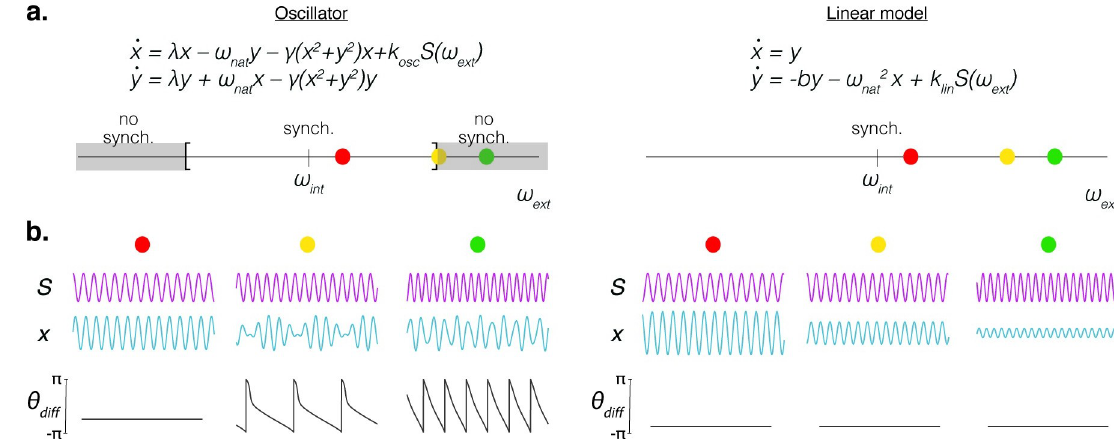
Fig 4. Comparison between an oscillator and a non-oscillator–like systems. (a) Upper panel: set of equations defining the different models. An oscillator-like model (Stuart–Landau) on the left; a linear model on the right. Lower panel: system’s behavior for different frequency values ( ω ext ) of the external rhythmic signal ( S ). For the oscillator, the synchronization between the system and the external force vanishes when the external frequency departs from the internal one (gray area in the left panel); for the linear model, instead, synchrony exists regardless of the value adopted by the external frequency. (b) Behavior of the 2 models (blue traces; oscillator on the left, linear model on the right) for rhythmic inputs (magenta traces) of different frequencies (colored dots; red, yellow, and green correspond to ω ext = 4.5, 5, and 6.2 Hz, respectively). The lower panel displays in gray the time evolution of the phase difference between the system output and the corresponding input.